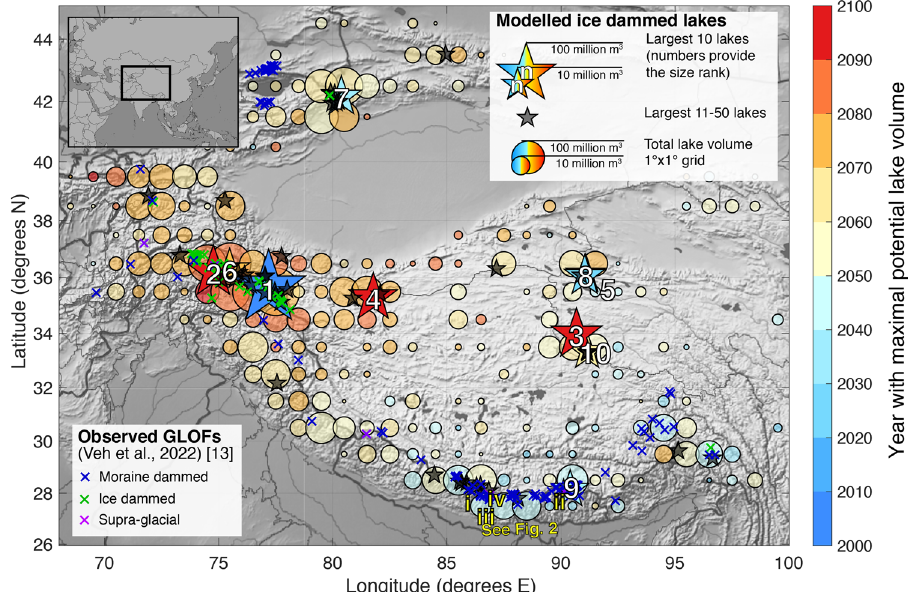
Fig. 5 Regional distribution of ice-dammed lakes and observed historical GLOFs in HMA. The map shows the ten largest modelled ice-dammed lakes by volume (coloured stars; rank given by white numbers; the star's size is proportional to the lake volume), the 11 – 50 largest modelled lakes (transparent stars without numbers), and the maximal lake volume aggregated for a 1° x 1° grid (coloured spheres, the size is proportional to the aggregated lake volume). The colour of both the stars and the spheres correspond to the decade in which the maximal lake volume is reached. Coloured crosses indicate observed GLOFs 13 and distinguish between three categories (legend given at bottom left). The yellow roman numerals correspond to the locations of the four glaciers shown in Fig. 2. Background map source: Natural Earth.